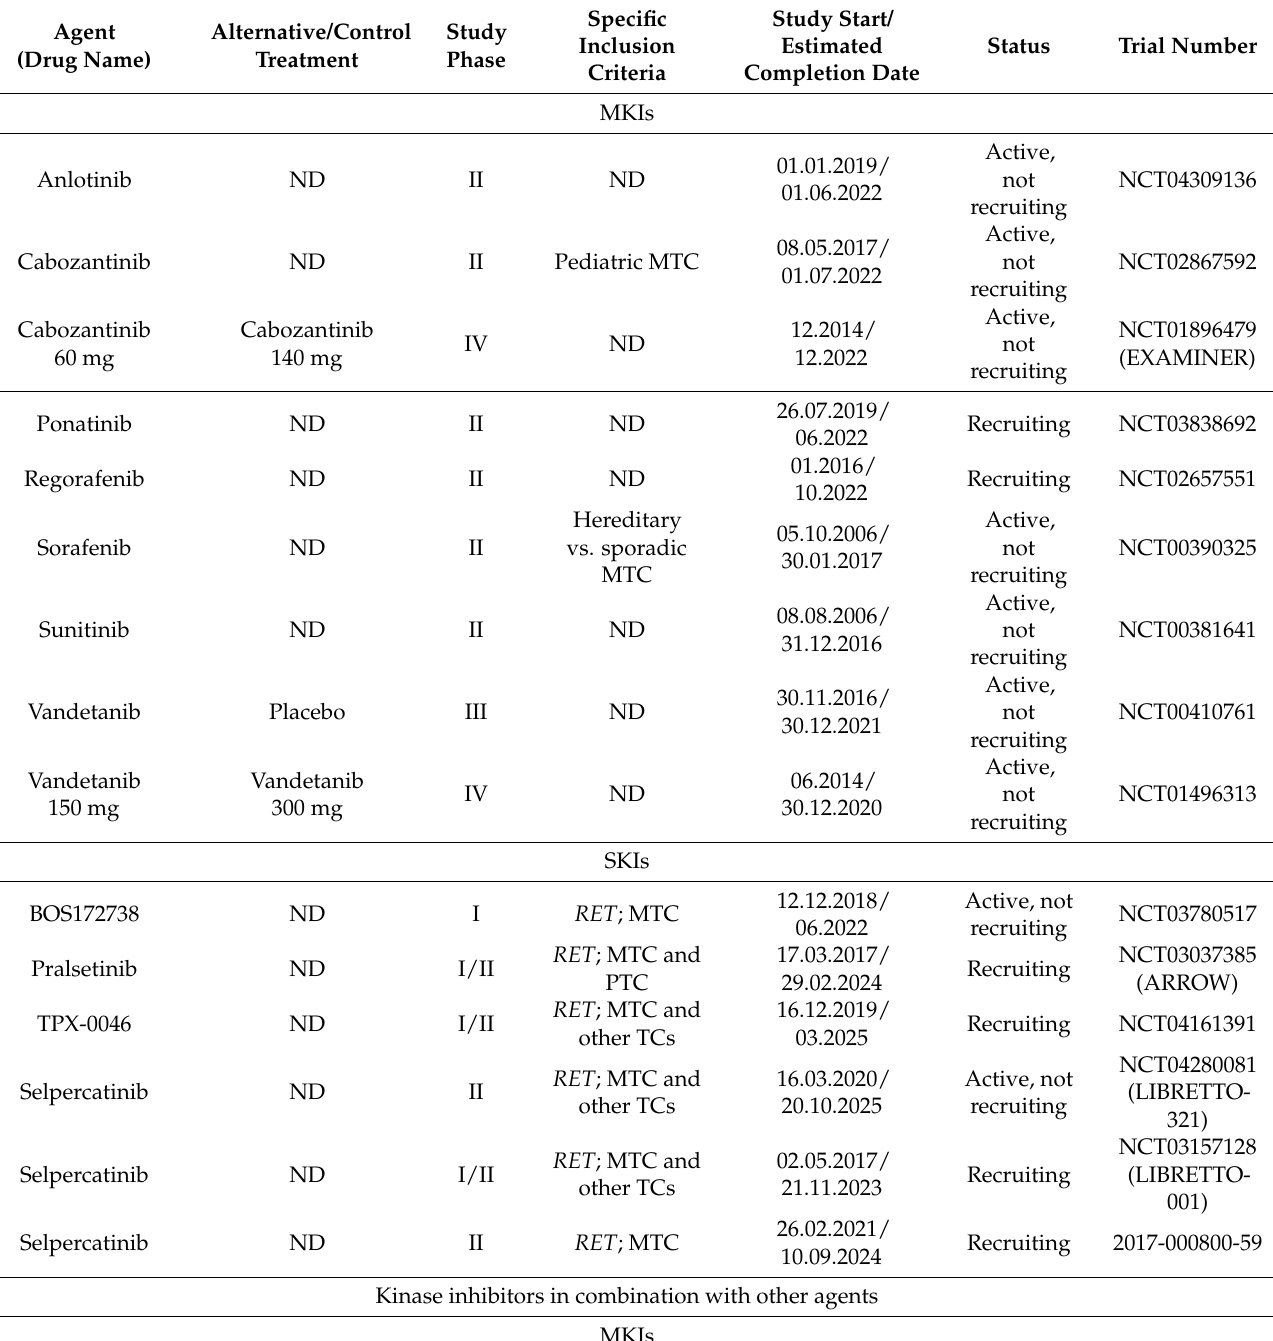
angiogenesis [13,61,105,155]. The list of on-going clinical trials for treatment of MTC is provided in Table 4. Table 4. Kinase inhibitors currently investigated in clinical trials for MTC treatment (registered under ClinicalTrials.gov and